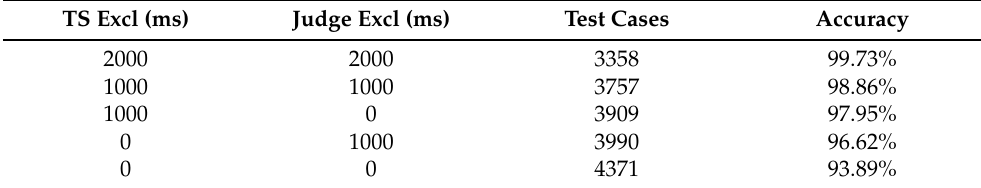
Table 4. Gait classification accuracy for different sizes of exclusion windows.